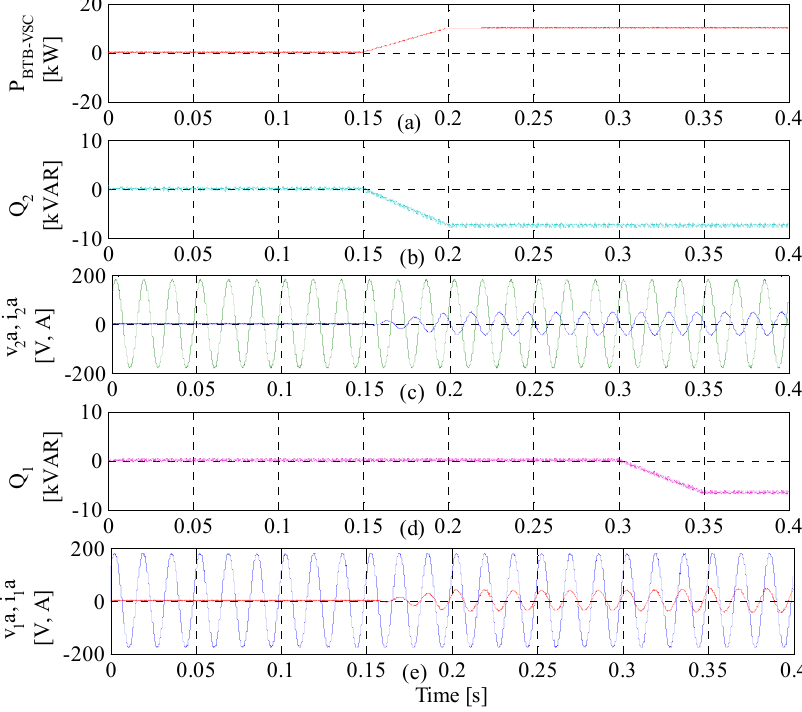
Figure 9. Performance of the BTB-VSC for Case 8. ( a ) Active power flowing between feeders. ( b ) Reactive power compensated by VSC 2 . ( c ) Voltage and current at terminals of VSC 2 . ( d ) Reactive power compensated by VSC 1 . ( e ) Voltage and current at terminals of VSC 1 .